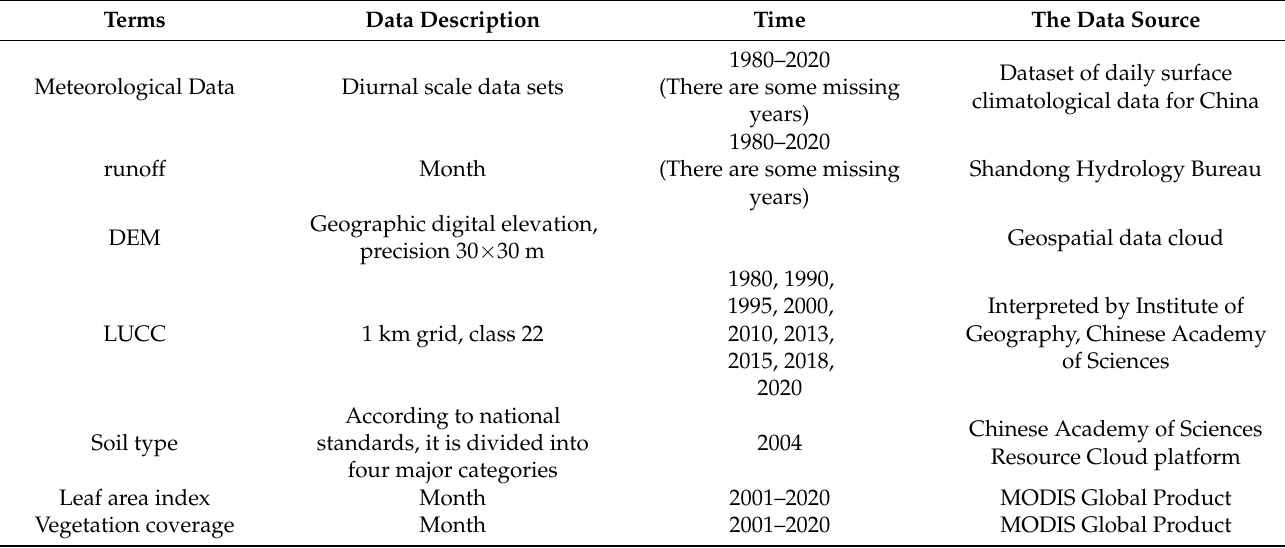
Table 1. Data description and source summary table, including data start and end times, accuracy, and data